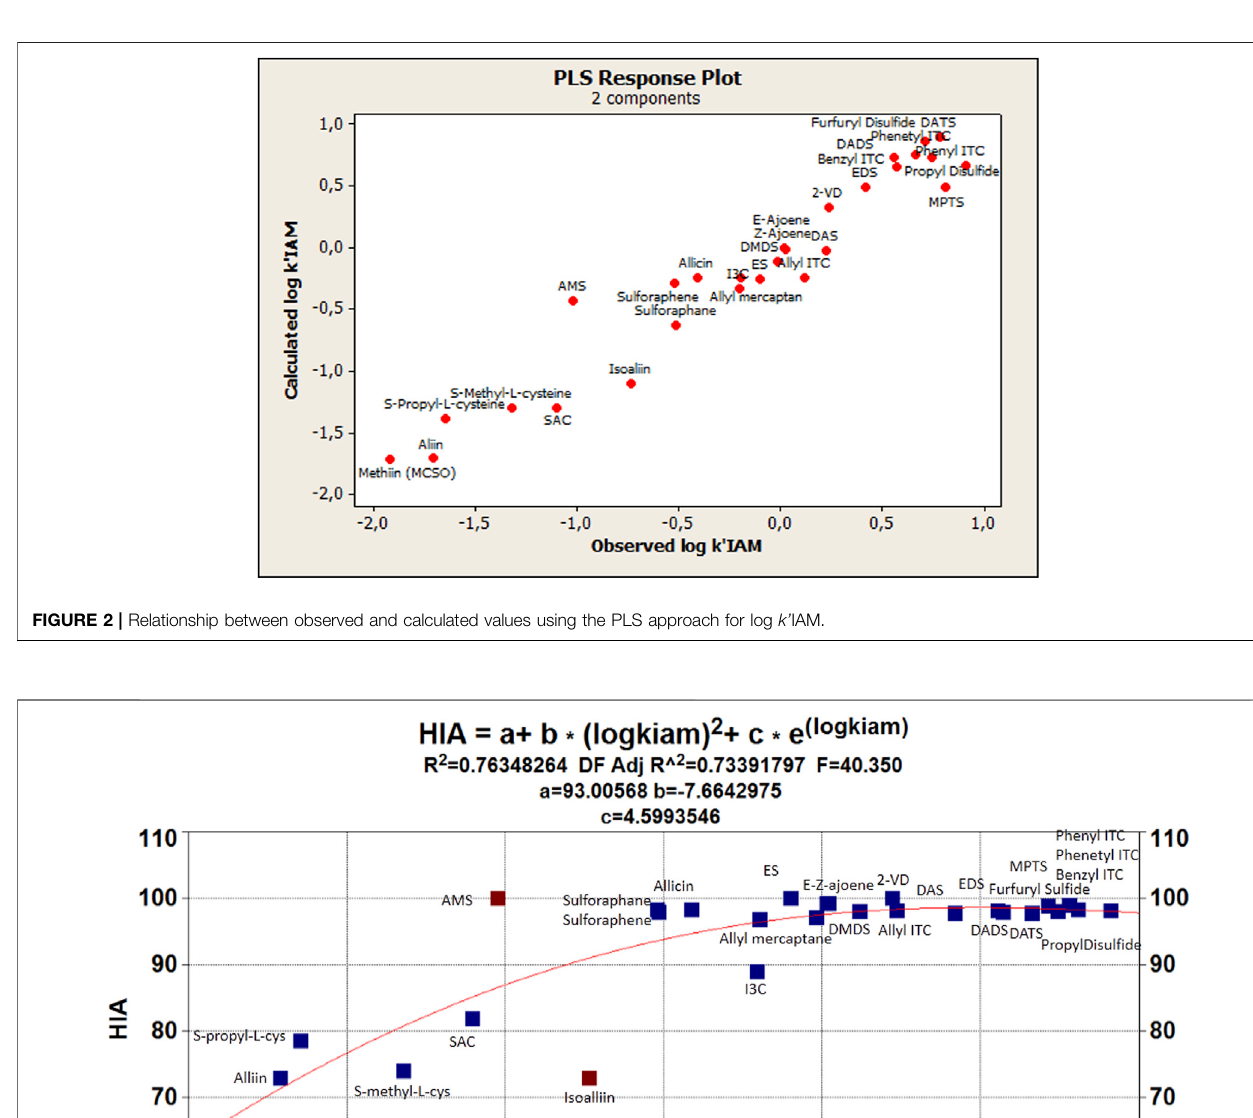
Frontiers in Chemistry |